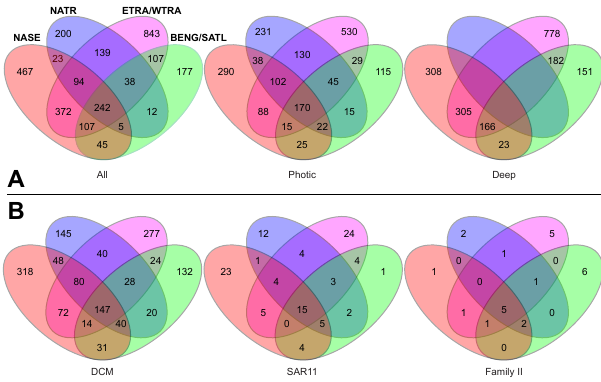
Fig. 4. Venn diagrams comparing the OTU richness identified in the Longhurst provinces sampled in this study. Panel A compares OTU richness identified in all the samples (All, n = 2871), samples from the photic zone (Photic, n = 1845), and samples from deep waters (Deep, n = 1913). Panel B compares OTU richness iden- tified in all the deep chlorophyll maximum zone samples (DCM, n = 1416). Also panel B compares the OTU richness identified in the DCM zone for two of the most abundant taxonomic fam- ilies, SAR11/ Pelagibacter ( n = 107) and Family II/Cyanobacteria ( n = 25). The studied provinces are grouped and labelled in the di- agram for all samples (ALL) as follows: North Atlantic Subtropical East (NASE, 3 samples), North Atlantic Tropical Gyral (NATR, 2 samples), Eastern and Western Tropical Atlantic (ETRA/WTRA; ETRA, 2 samples; WTRA, 8 samples), and South Atlantic Gyral and Benguela Current Coastal (BENG/SATL; BENG, 3 samples; SATL, 1 sample). The photic diagram compares two samples each for NASE, NATR, and BENG/SATL provinces and five samples for the ETRA/WTRA provinces. The deep diagram compares one sam- ple each for NASE and BENG/SATL provinces and three samples for ETRA/WTRA provinces. The DCM, SAR11 and Family II dia- grams compare one sample for the NATR province and two samples for each one of the other provinces. Samples from the DCM, photic, and deep zones were defined as in Fig.